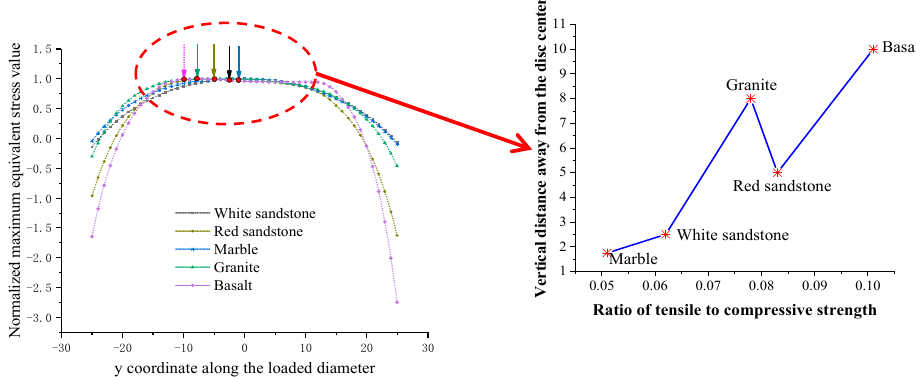
Figure 7. The distribution of the Mohr equivalent stress along the loaded diameter for di ff erent rock